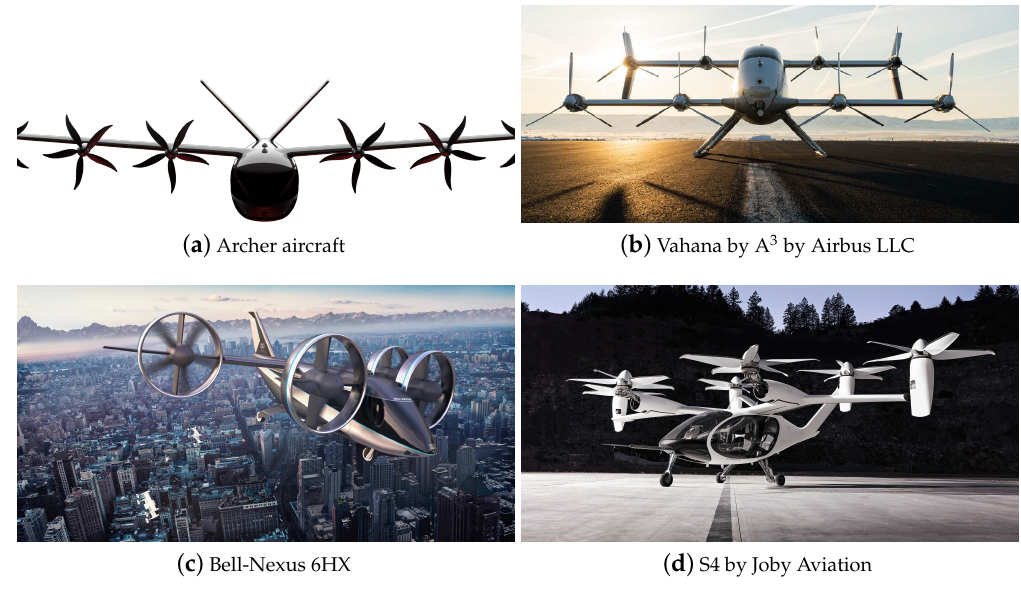
Figure 1. Examples of eVTOLs aircraft architectures (from https://evtol.news/aircraft): ( a ) Archer aircraft, https://www.flyarcher.com/; ( b ) Vahana by A 3 by Airbus LLC, https://acubed.airbus.com/ projects/vahana/; ( c ) Bell-Nexus 6HX by Bell, https://www.bellflight.com/products/bell-nexus; ( d ) S4 by Joby Aviation,